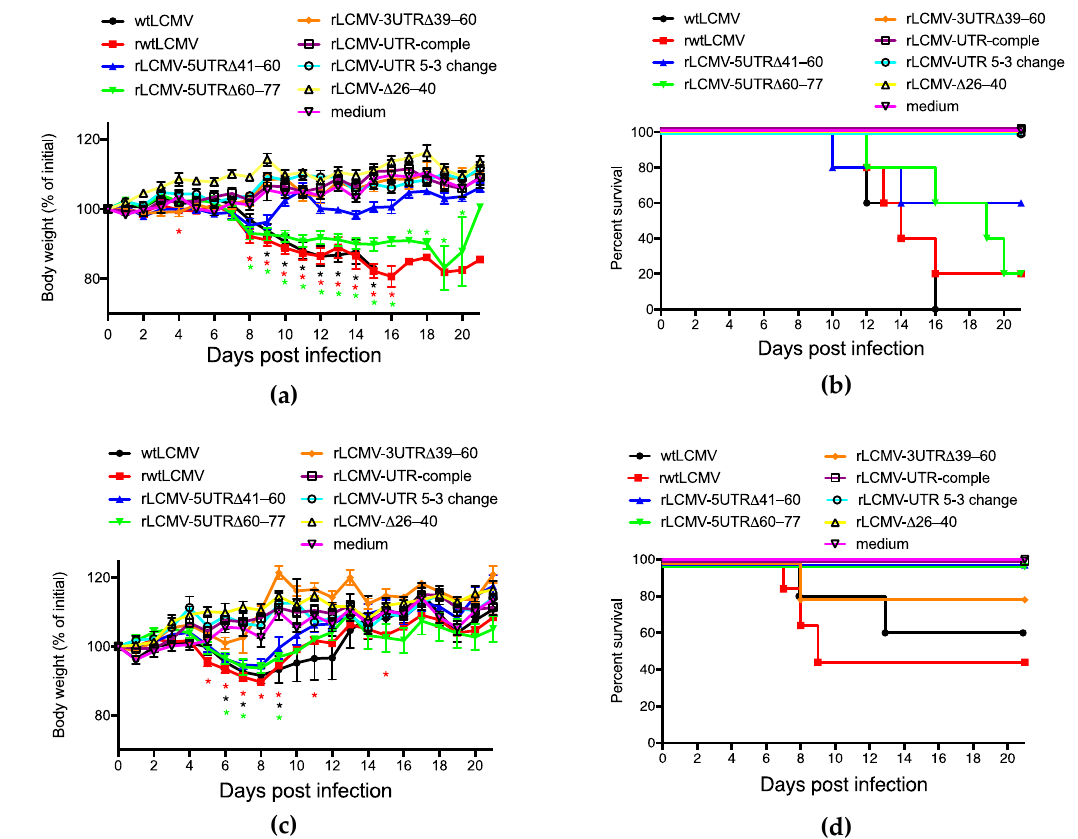
Figure 4. Virulence of wtLCMV and rLCMVs in CBA/NSlc mice and DBA/1JJmsSlc mice: ( a , b ) Changes in body weight and survival rate of CBA/NSlc mice. Seven-week-old female CBA/NSlc